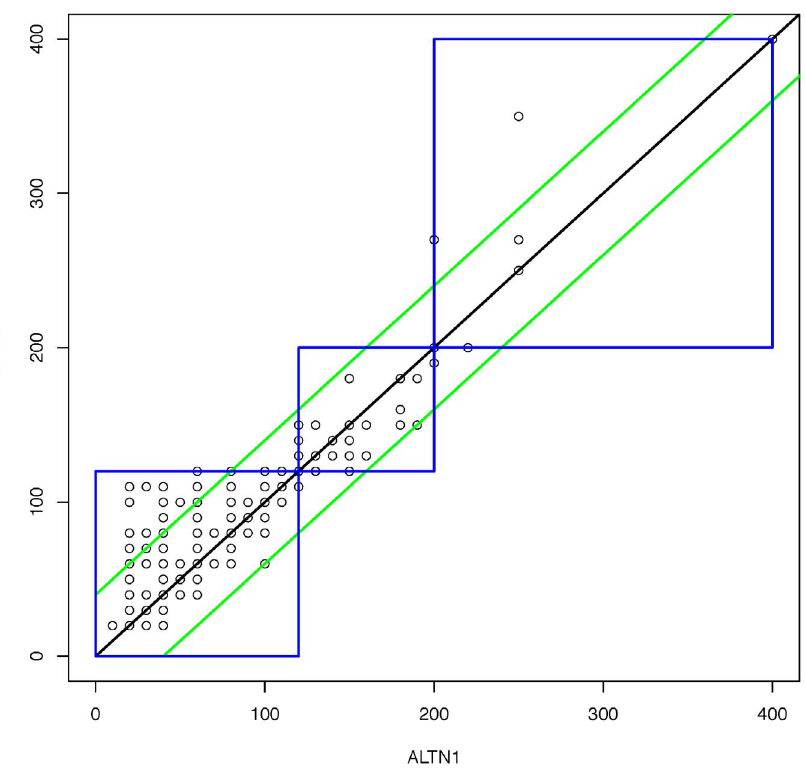
Figure 3. Analysis of inter-reader agreement. Visual ALT results recorded by Nurse 1 (ALTN1) were plotted against visual ALT results recorded by Nurse 2 (ALTN2) for each device to evaluate inter-reader agreement. The black diagonal line corresponds to the line of equality; the green diagonal lines correspond to + / 2 40 U/L from the line of equality; and the blue boxes represent ALT bins within which values for both readers are within the same range: , 3x ULN (0–119 U/L), 3 to 5x ULN (120–200 U/L), or . 5x ULN ( . 200 U/L). (ALT=alanine aminotransferase. ULN=upper limit of normal).